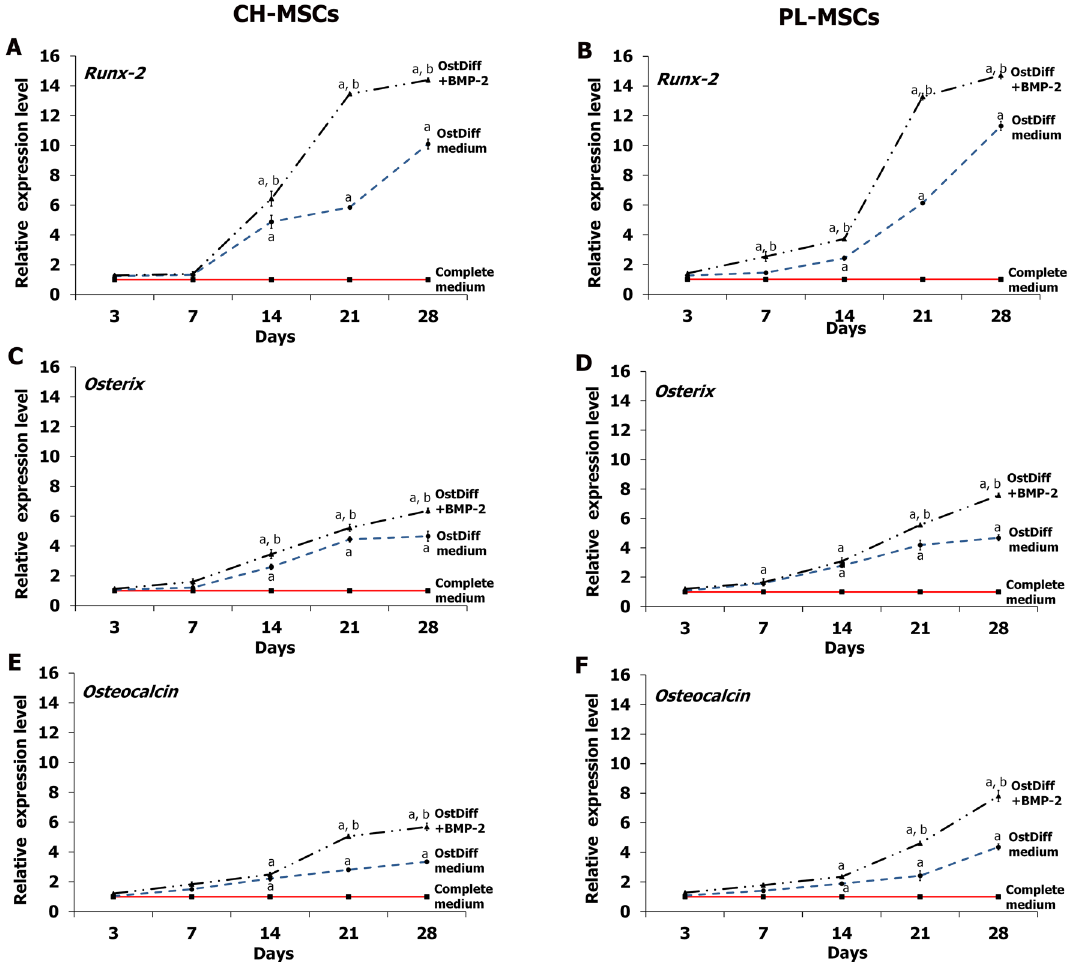
Figure 3. The expression of osteogetic markers in CH-MSCs ( A , C , E ) and PL-MSCs ( B , D , F ) cultured in osteogenic differentiation medium with or without BMP-2. Real-time RT-PCR analysis of Runx-2, Osx, and Ocn expression relative to GAPDH was performed at the indicated time points. p <0.05 compared to MSCs cultured in complete DMEM medium marked as “a”. p <0.05 compared to MSCs cultured in osteogenic differentiation medium (OstDiff medium) marked as